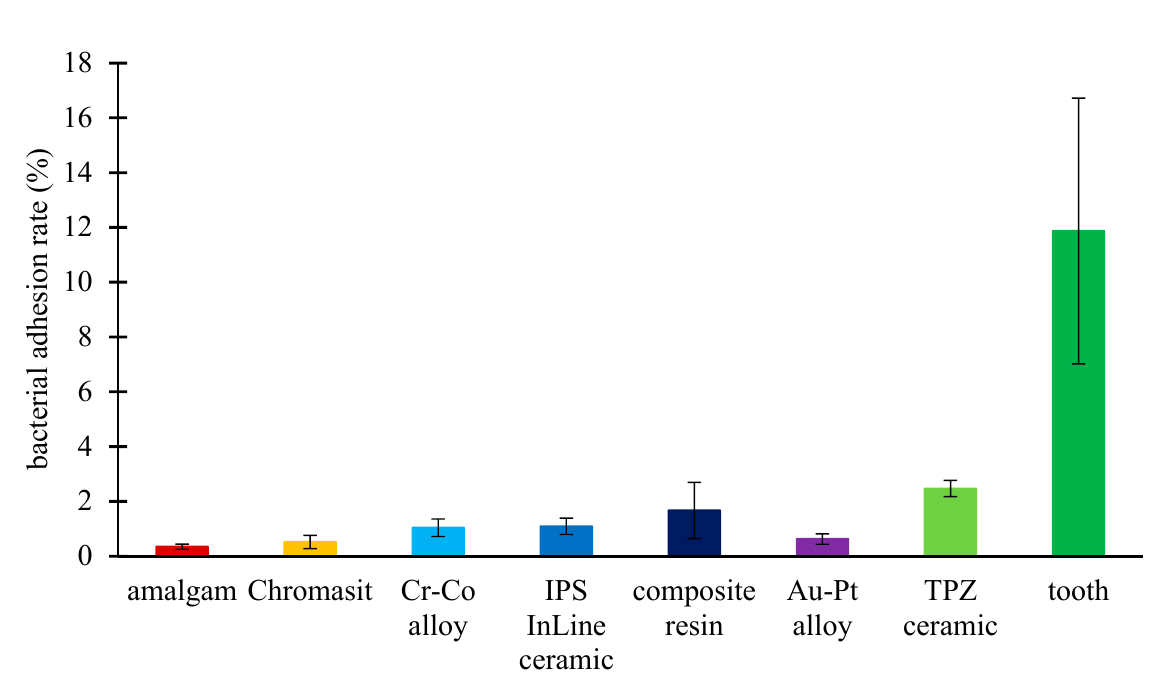
Figure 6. Bacterial adhesion extent on the following dental material surfaces after 10 h incubation: amalgam, Chromasit, Co-Cr alloy, IPS InLine ceramic, resin-based composite, Au-Pt alloy, TPZ ceramic, and tooth. The t -test analyses for bacterial extents are as follows. Amalgam/Chromasit: p = 0.0025; amalgam/Au-Pt alloy: p = 0.00001; amalgam/Co-Cr alloy, IPS InLine ceramic, composite resin, TPZ ceramic, and tooth: p < 10 − 5 .